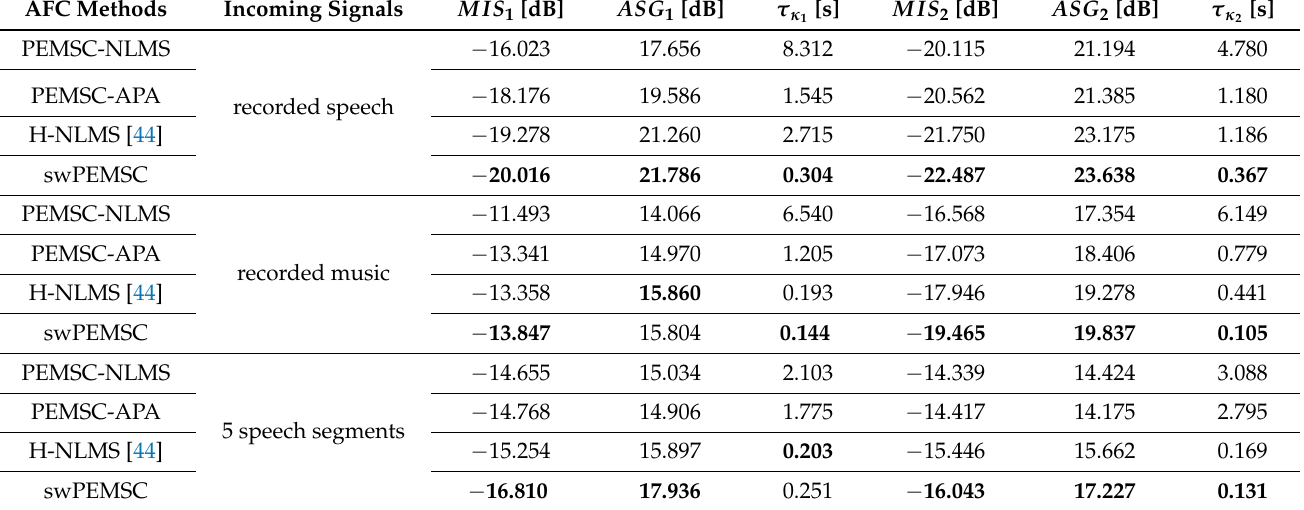
Table 2. Evaluate performance of PEMSC-NLMS, PEMSC-APA, H-NLMS, and swPEMSC for different types of the incoming signals, feedback path changes from F 1 to F 2 after half of the simulation time, κ 1 = − 15 dB, κ 2 = − 16 dB (for recorded speech input); κ 1 = − 11 dB, κ 2 = − 14.5 dB (for recorded music input); and κ 1 = κ 2 = − 13.5 dB (for 5 segments of speech input).